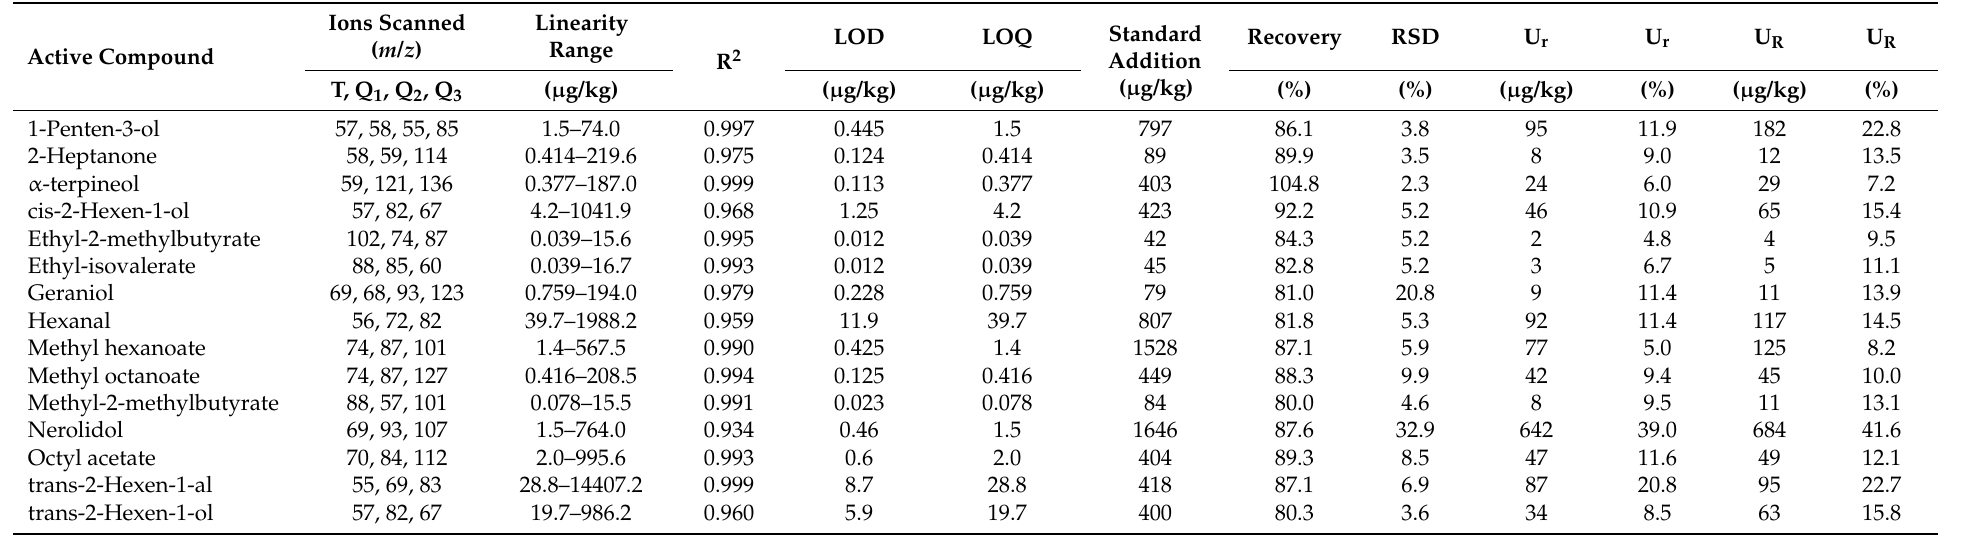
Table 1. Validation parameters for GC-MS